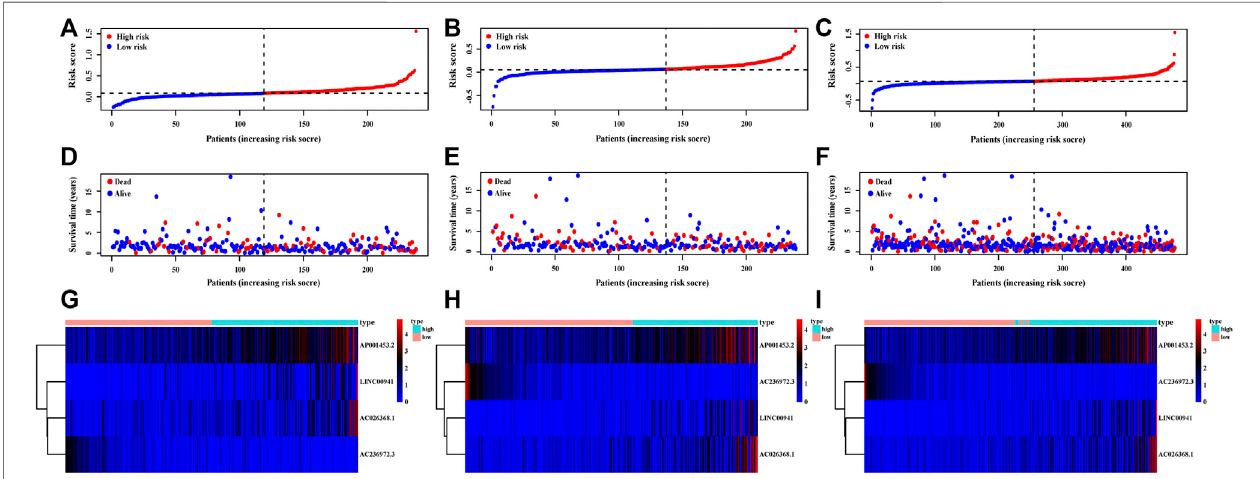
FIGURE 3 | Distribution of LUAD patients strati fi ed by the necroptosis-related lncRNA signature (NRLsig). (A – C) The distribution of low-risk group and high-risk group LUAD patients divided by the NRLsig in the training, validation, and entire set, respectively. (D – F) Survival statuses of patients in different groups strati fi ed by the NRLsig in the training, validation, and entire set, respectively. (G – I) Heatmap of expression statuses of the selected necroptosis-related lncRNAs in the training, validation, and entire set,